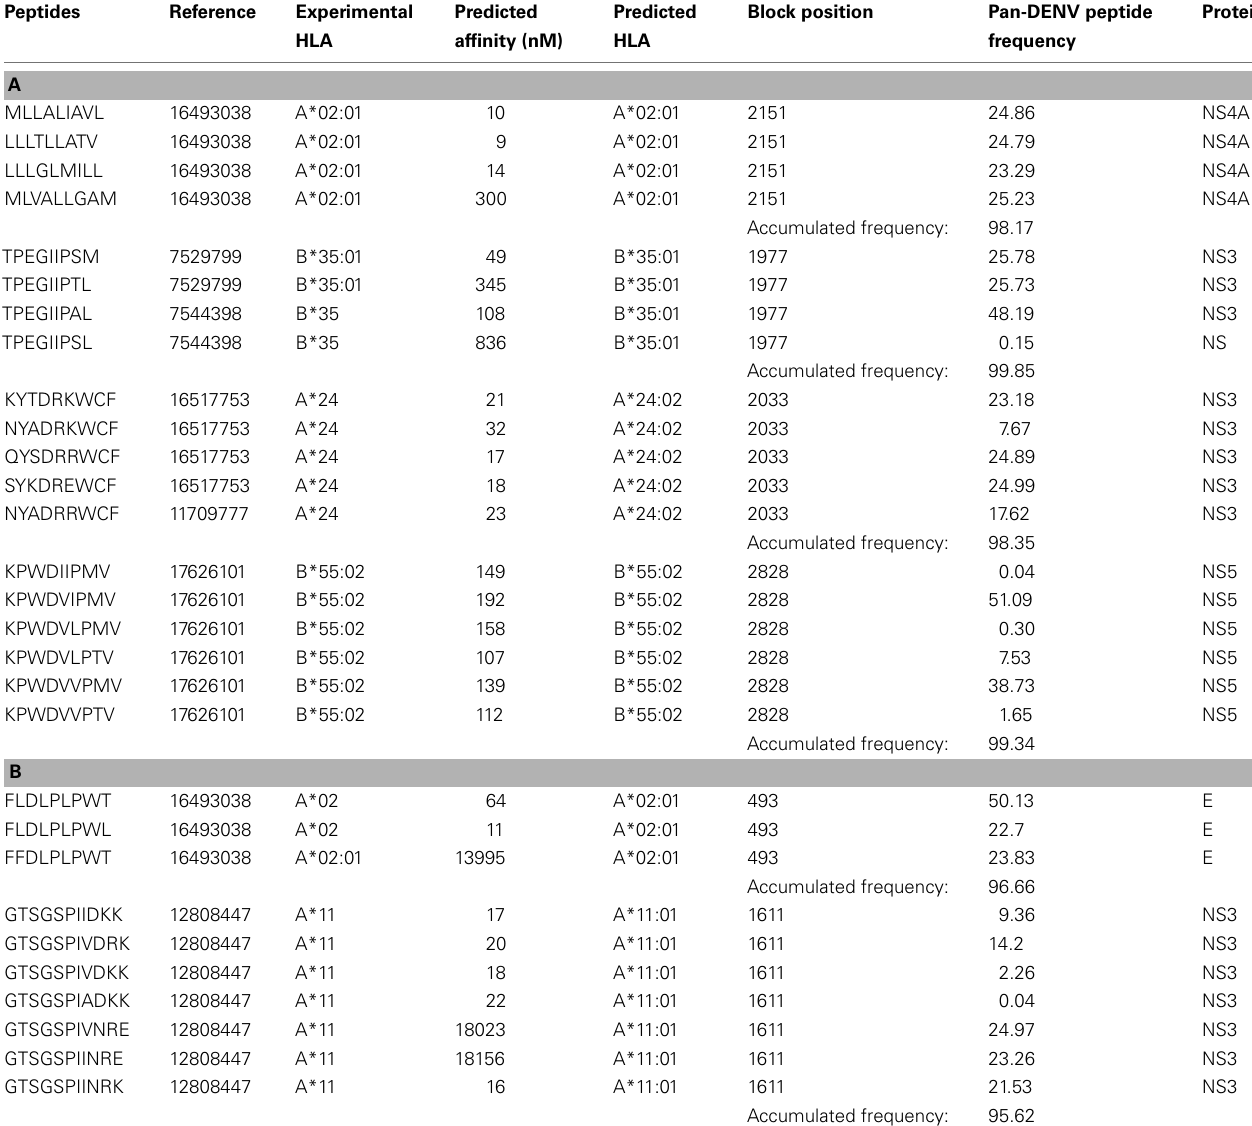
Table 7 | (A) Examples of experimental evidence supporting the application of the block entropy approach to achieve broad coverage by including homologous peptide blocks in polyvalent vaccine constructs. In the four examples below, a high percentage of pan-DENV population coverage was achieved by including only blocks of peptides that have all been predicted, as well as experimentally validated, to bind HLA. Predictions for B*55:02 were done using netMHCpan 2.4 (PMID: 17726526). (B) Two examples of blocks of experimentally validated epitopes, for which the block entropy approach failed to account due to epitope predictions inconsistent with the experimental findings of the respective